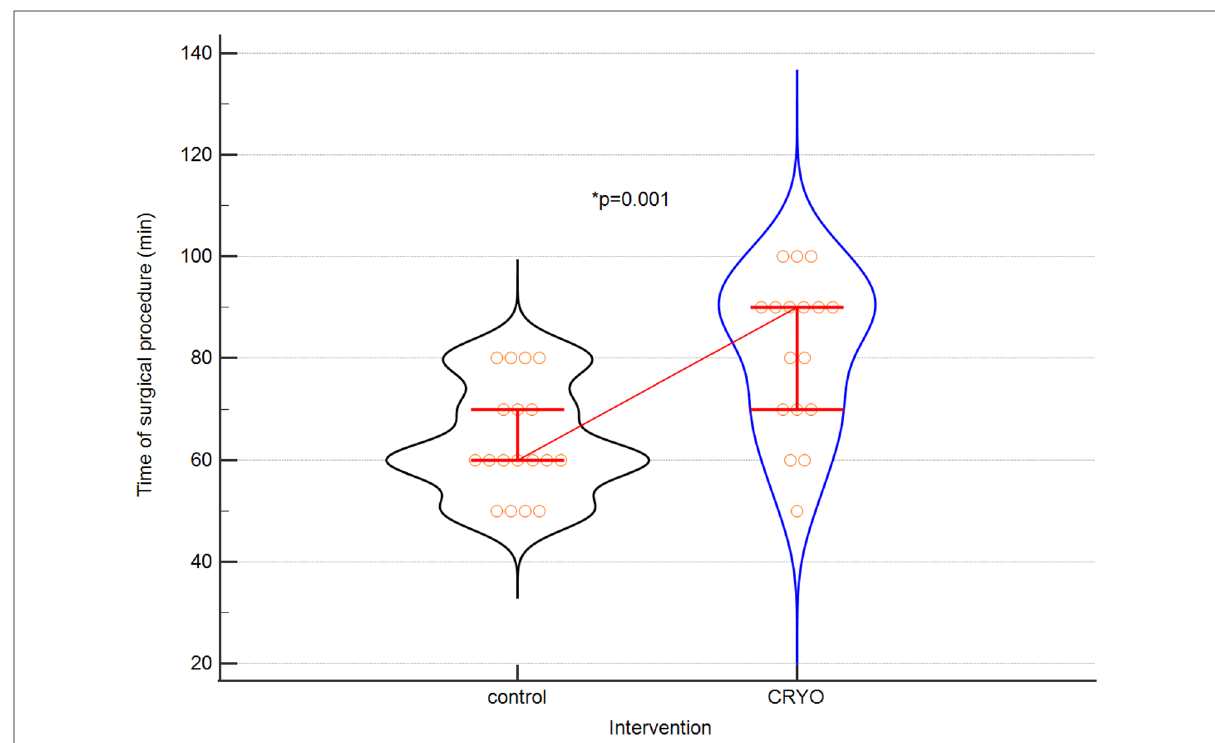
FIGURE 2 The difference between hospitalization time of both groups. Violin plot for hospitalization time. Medians and IQRs are shown. Circles depict individual cases. CRYO means interventional